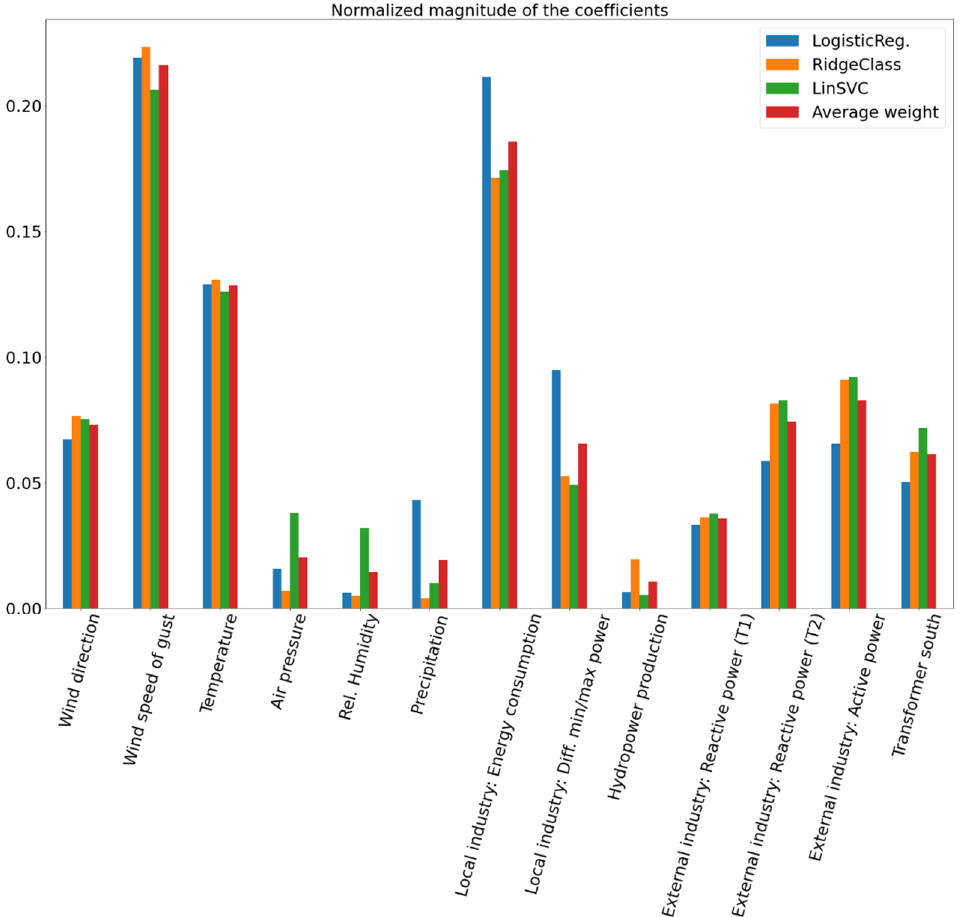
Figure 8. Coefficient magnitude assigned to each feature by the different linear models. In addition, the average weight of the different linear models is computed for each feature. High magnitude corresponds to an important feature in explaining power